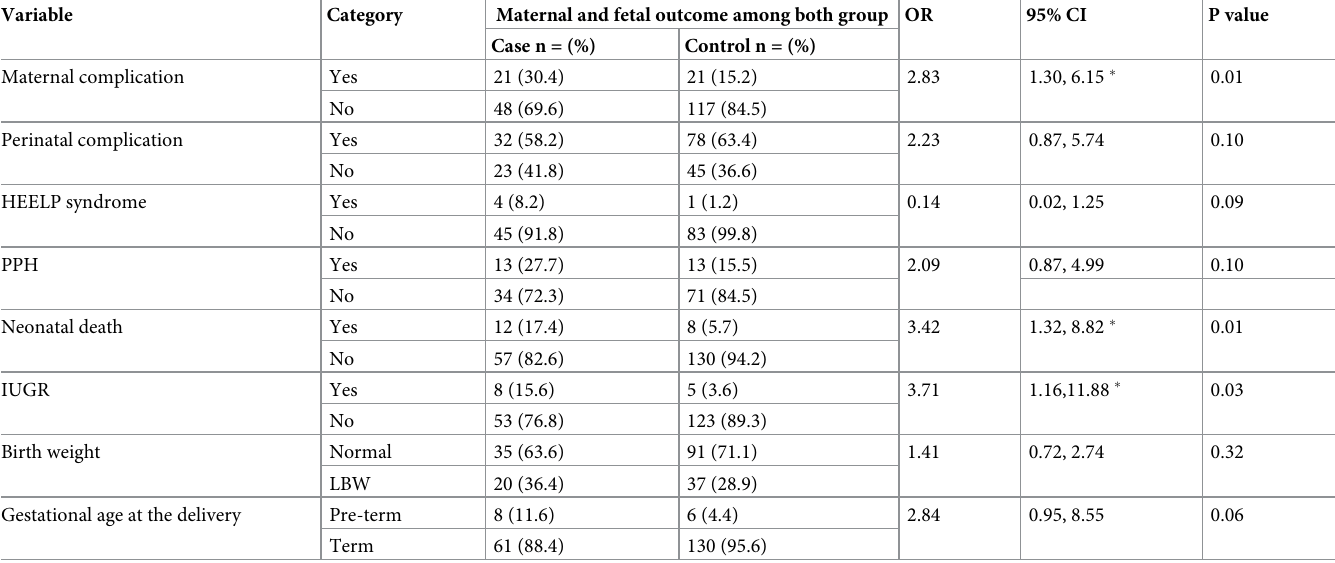
Table 4. Maternal and foetal outcome among women gave birth in Hossana town administration, southern Ethiopia, 2018.